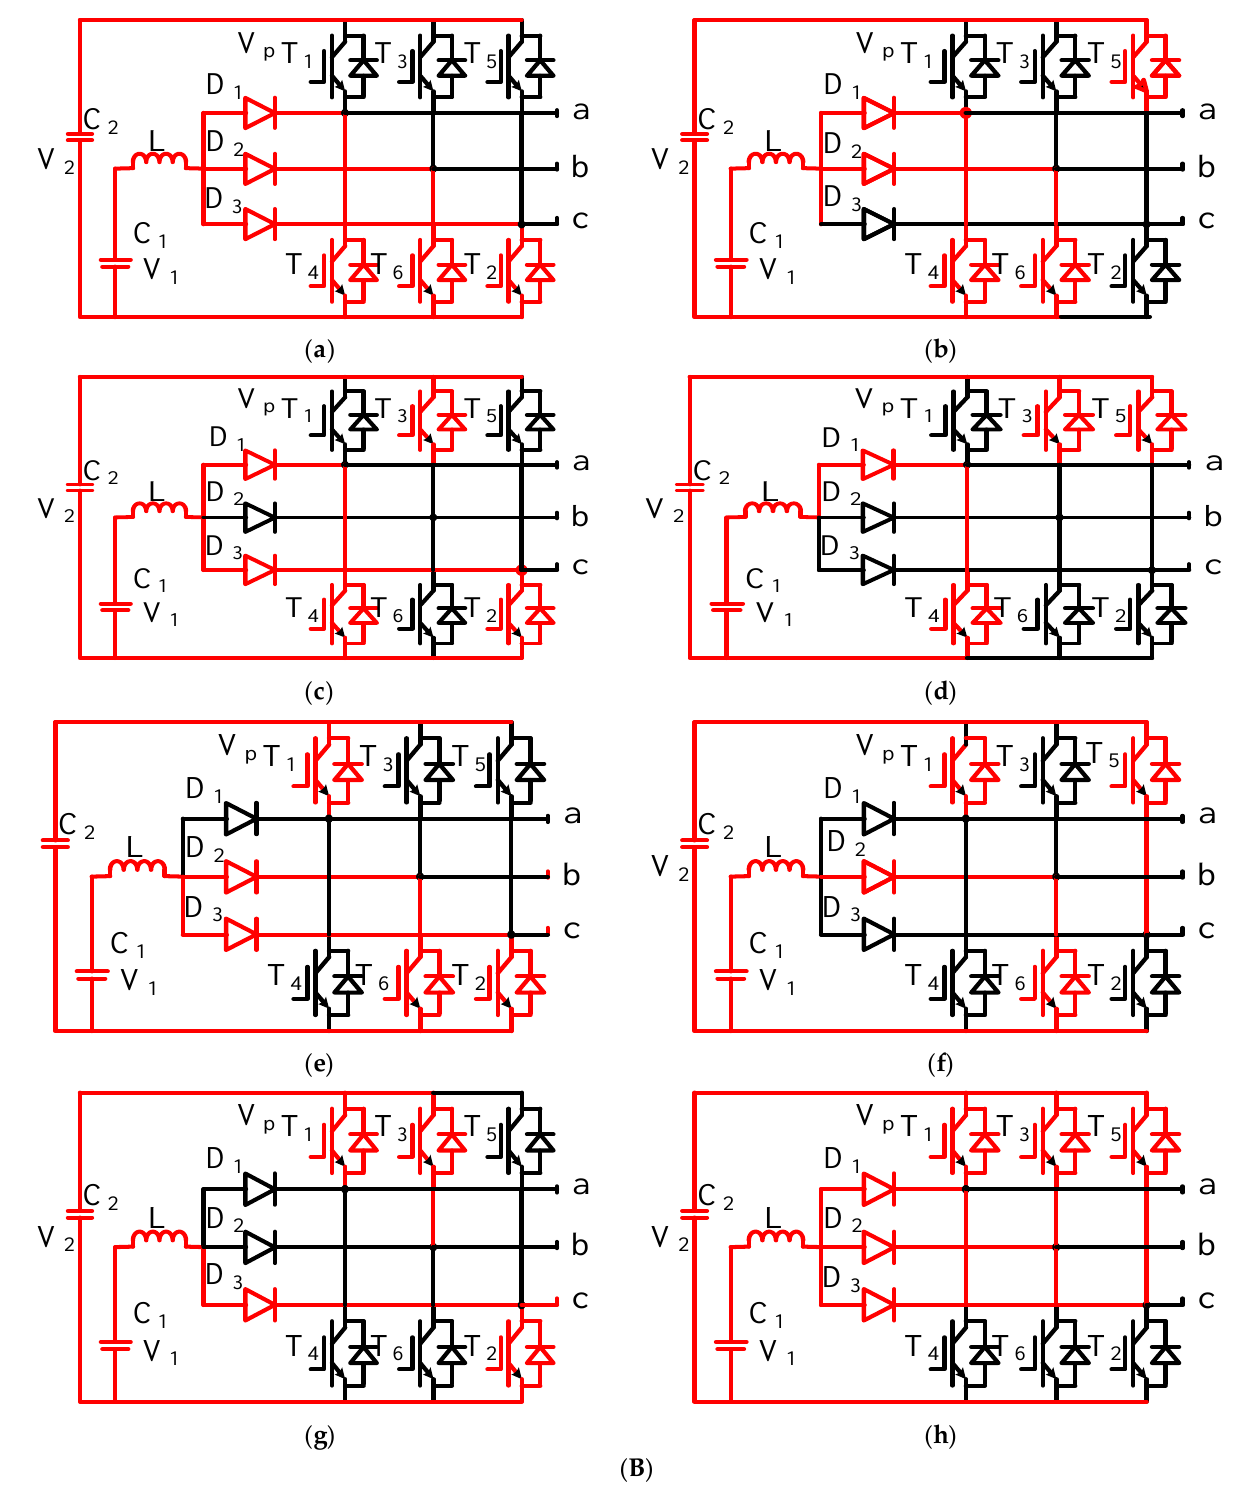
Figure 2. ( A ) Topology of SSI ( B ) ( a – h ) Modes of operation of SSI with inductor charging and discharging. According to the modes of operation, the circuit operates as boost converter in con- tinuous conduction mode where switches in the inverter are in conduction state (i.e.,) L will be charged for a period of T on and discharging for a period T of f The duty cycle 𝛿 given by Equation (1):